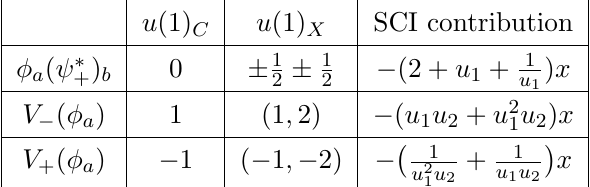
Table 3 . Descents of SU(3) (cid:13)avor current